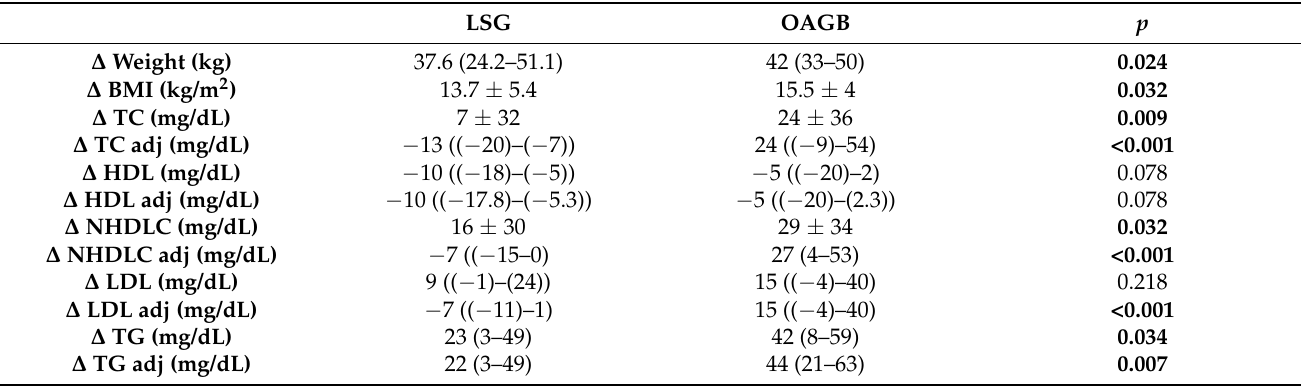
Figure 1. Prevalence (percentage) of dyslipidemia before (black bars) and after (grey bars) laparo- scopic sleeve gastrectomy (LSG) ( n = 88) and one anastomosis gastric bypass (OAGB) ( n = 46). Statistical analysis was performed by Chi-square test. Table 4. Difference between the changes (delta ∆ ), before and after laparoscopic sleeve gastrectomy (LSG) and one anastomosis gastric bypass